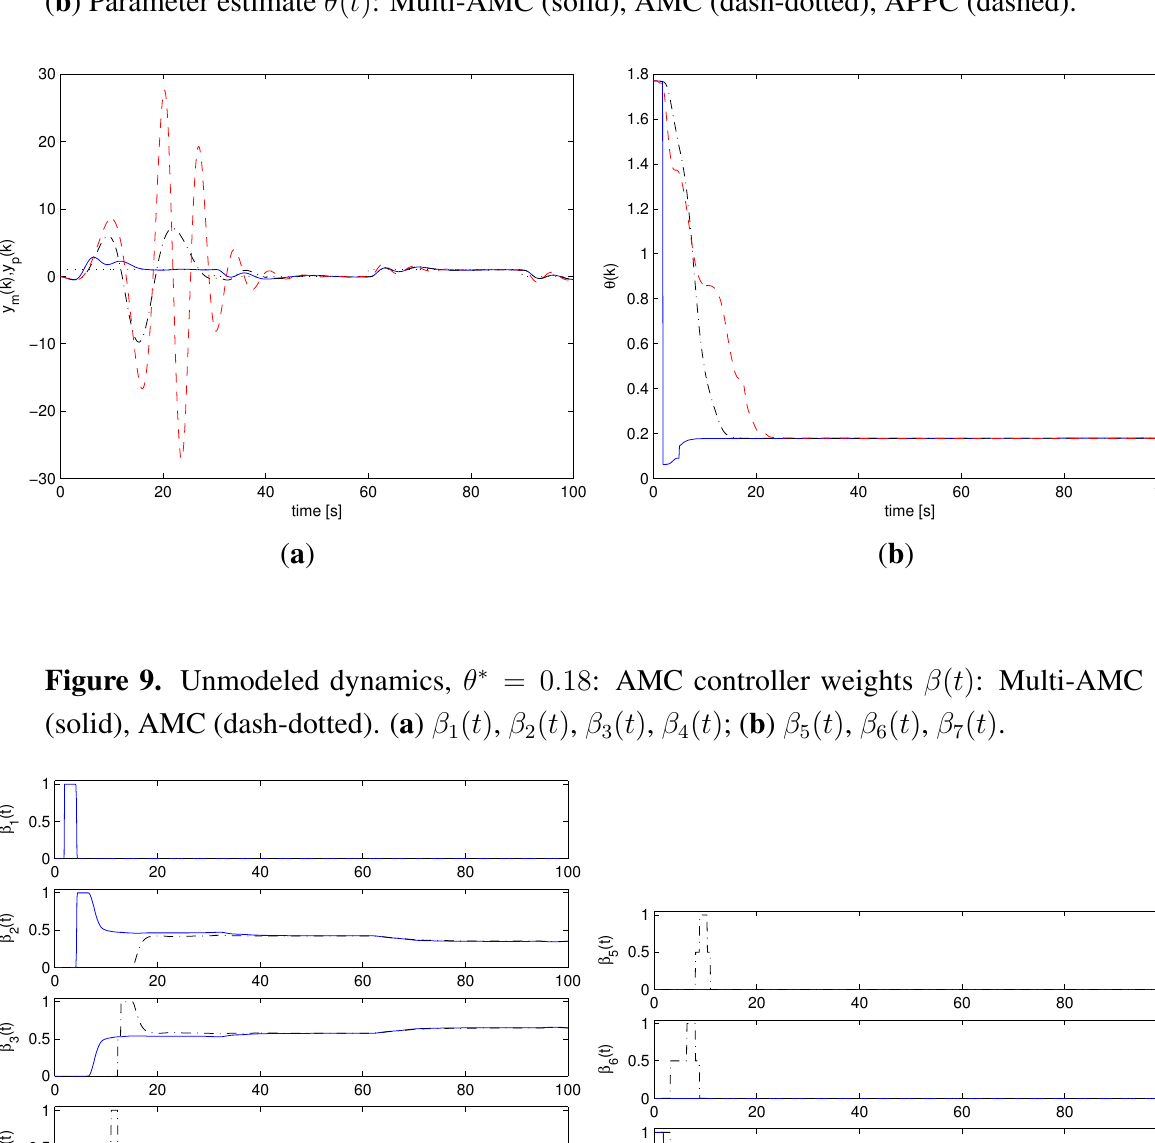
Figure 8. Unmodeled dynamics, θ ∗ = 0 . 18 : Multi-AMC (solid), AMC (dash-dotted), APPC (dashed). ( a ) output response y ( t ) : Multi-AMC (solid), AMC (dash-dotted), APPC (dashed); ( b ) Parameter estimate θ ( t ) : Multi-AMC (solid), AMC (dash-dotted), APPC (dashed).